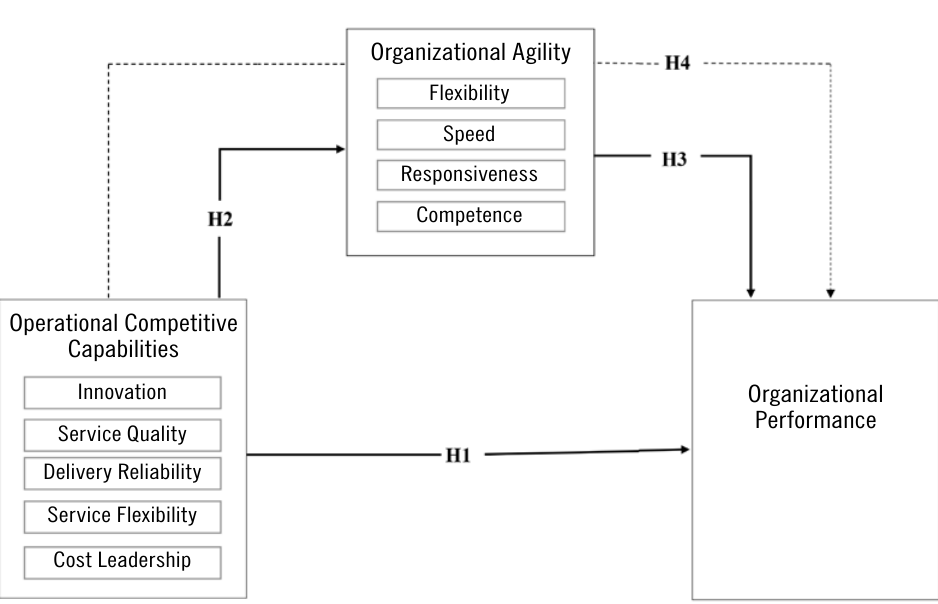
Figure 1. Research